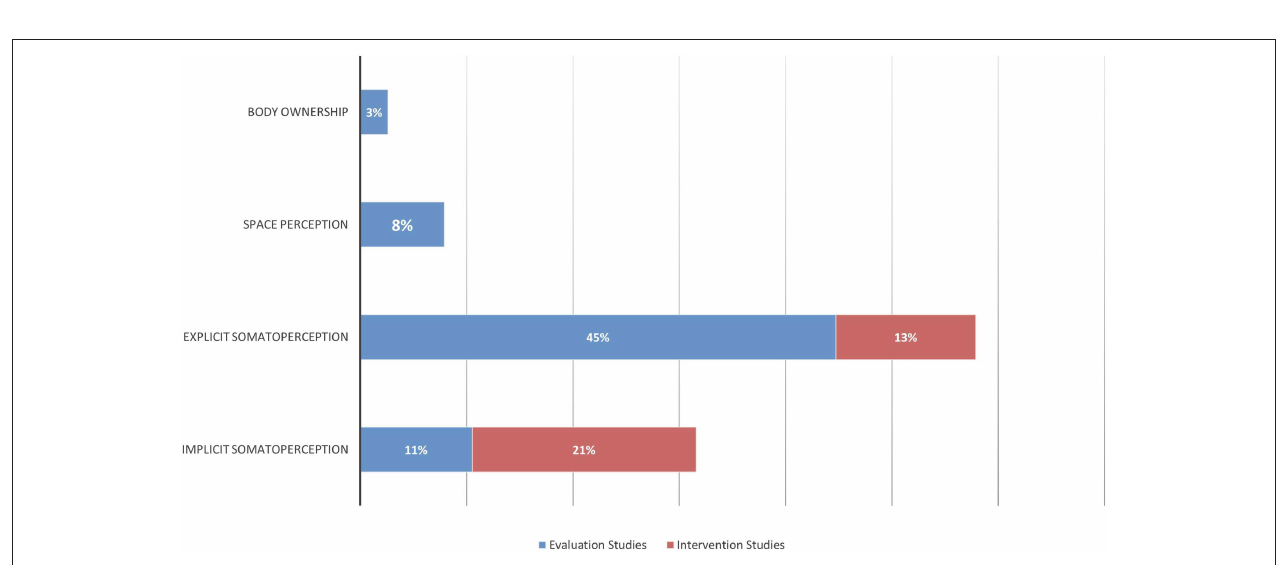
FIGURE 3 | Summary of the distribution of included studies for clinical conditions examined.